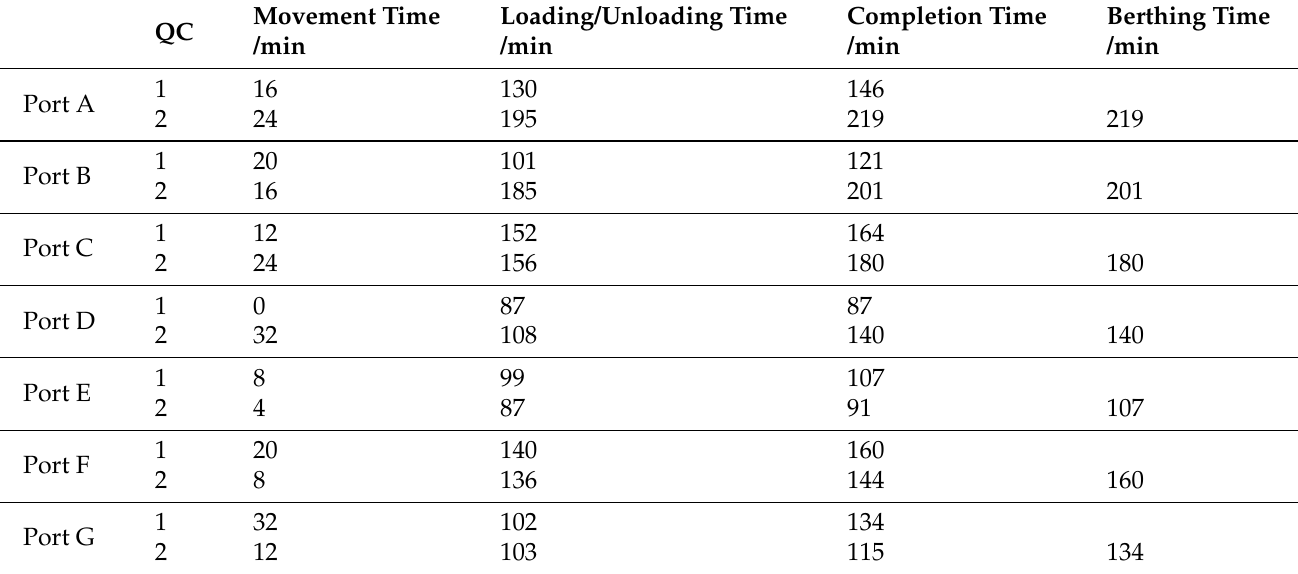
Table 6. Results of the double-bay rule allocation.